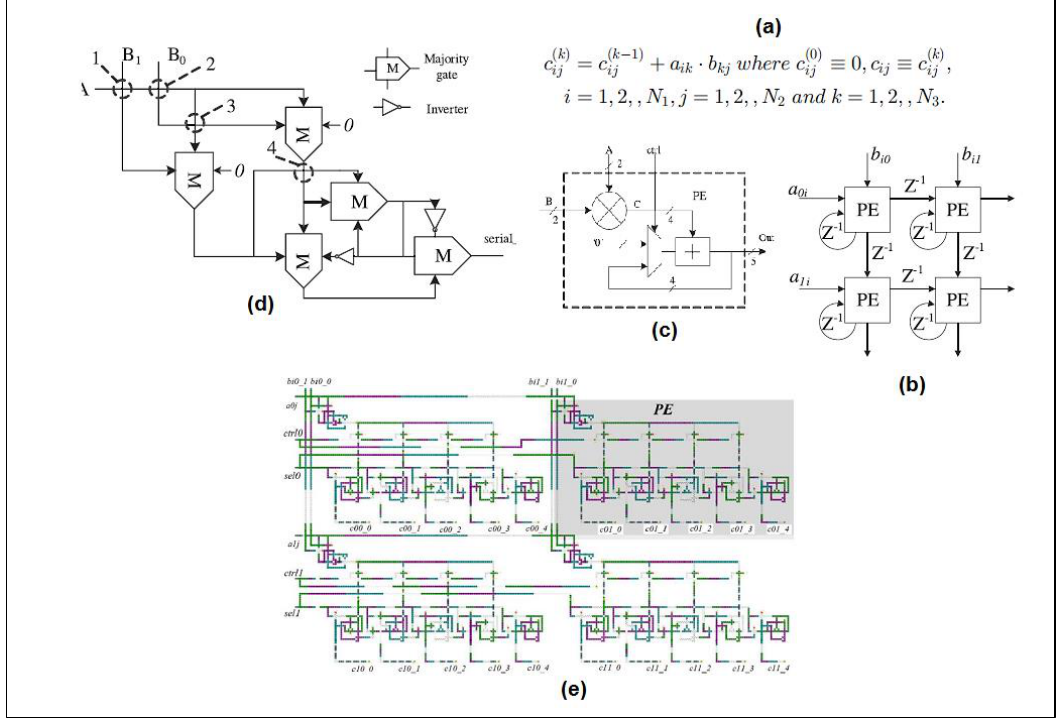
Figure 6. (a) Single instruction function, (b) Data Graph, (c) Selected PE, (d) the Schematic based on Majority gate, (e) Design of 𝟐 × 𝟐 Matrix multiplier based on QCA systolic